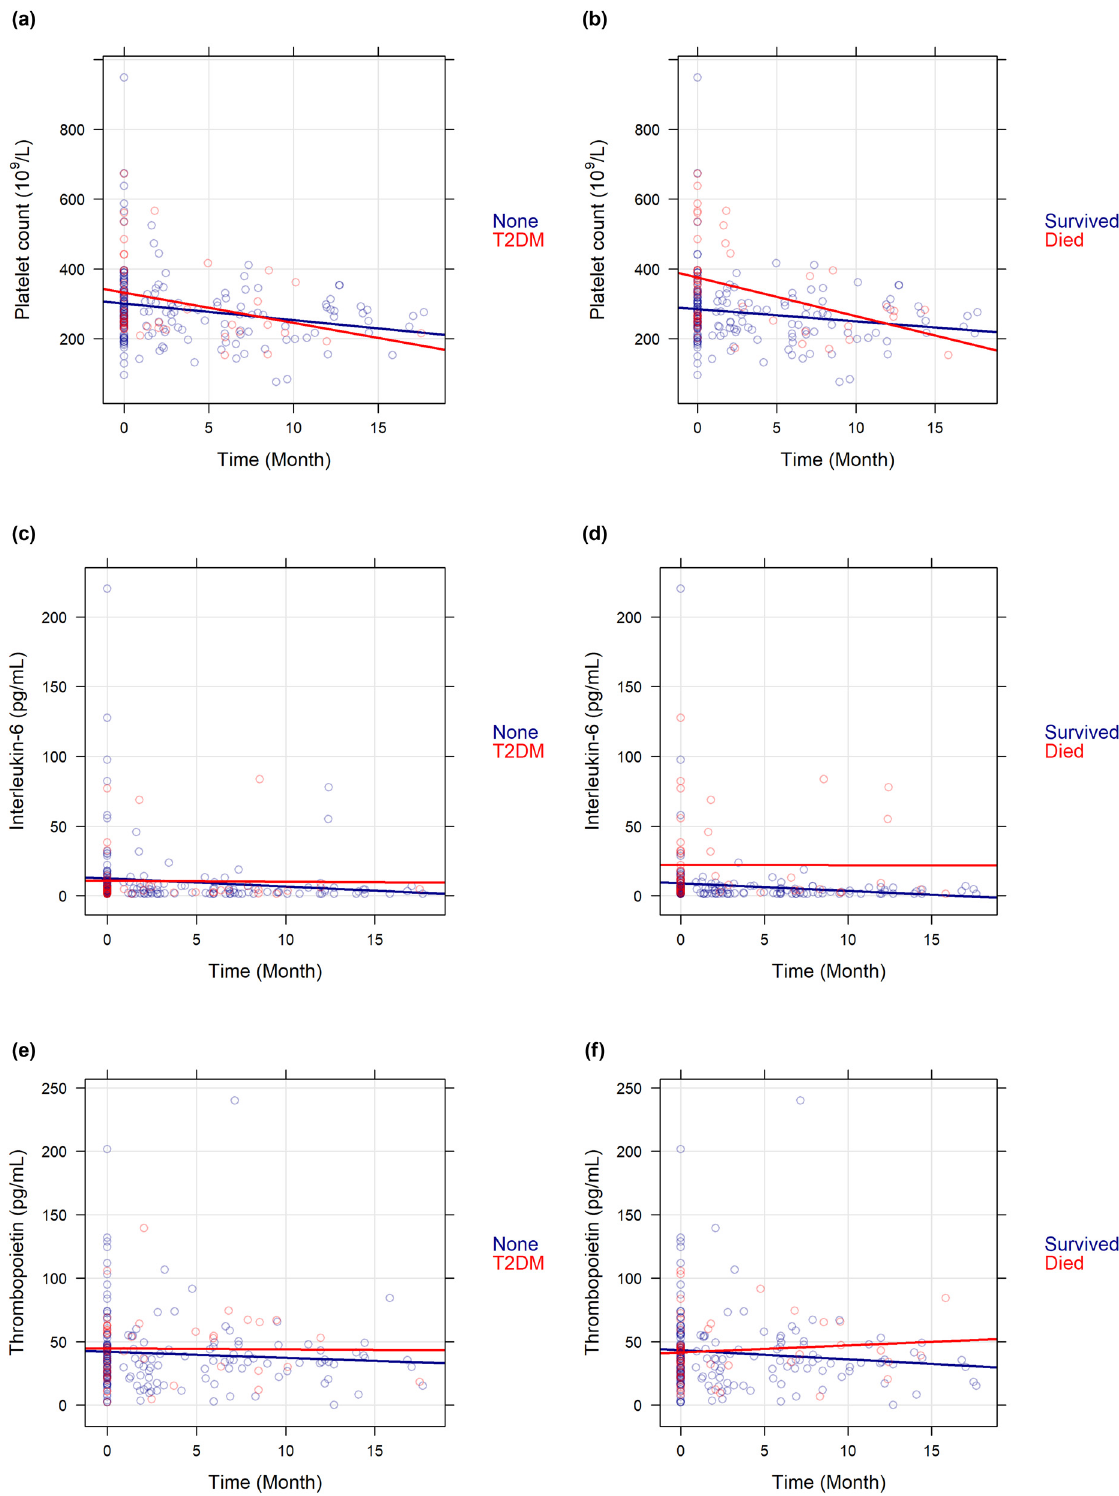
Figure 2: Change in the parameters of paraneoplastic thrombocytosis with the course of the disease. No di ff erence was found in any of the parameters ( a, c, e ) when strati fi ed with the presence of T2DM. ( b ) Platelet count and ( d ) plasma interleukin - 6 were signi fi cantly higher at the time of CRC diagnosis in those patients who died during the observation period. Within the fi rst year after tumor removal surgery, a signi fi cantly faster platelet count decrease was found in those patients who died ( b ) , whereas the signi fi cant di ff erence in plasma interleukin - 6 levels remained throughout the whole study between survivors and those patients who died ( d ) . No statistical di ff erence was found in plasma thrombopoietin levels of survivors and nonsurvivors ( p = 0.5940, f )